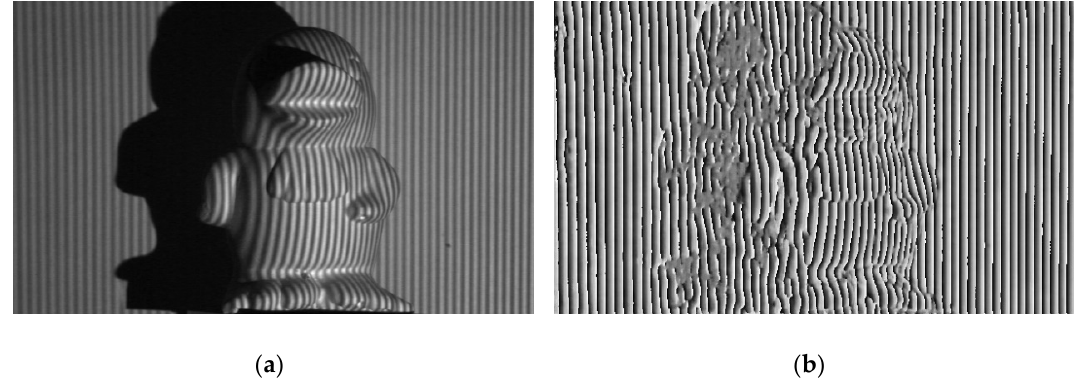
Figure 10. Fringe image and wrapped phase map calculated using the proposed method: ( a ) Fringe image of the single-shot 3D shape reconstruction dataset; ( b ) Wrapped phase map calculated using the proposed method.